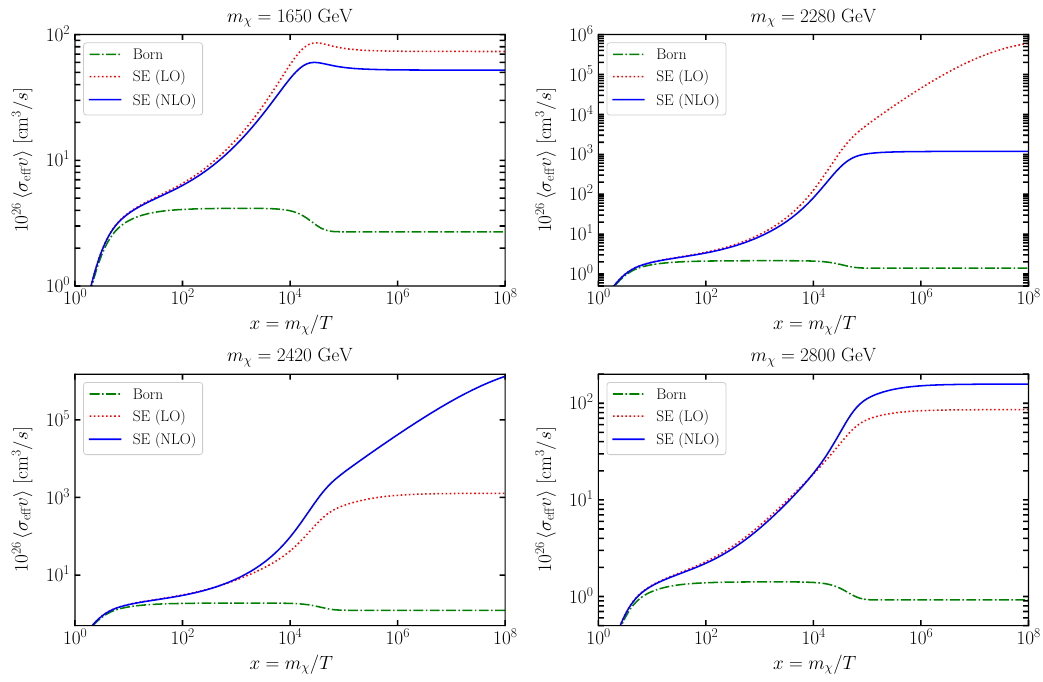
Figure 7 . The thermally-averaged cross section h σ eff v i in the Born approximation (green/dot- dashed), and with the Sommerfeld enhancement from the LO (dotted/red) and NLO (solid/blue) potential as a function of x = m χ /T . We show h σ eff v i for mass values below the first resonance ( m χ = 1 . 65 TeV) and above ( m χ = 2 . 8 TeV), and near the first resonance of the LO ( m χ = 2 . 28 TeV) and the NLO ( m χ = 2 . 42 TeV)